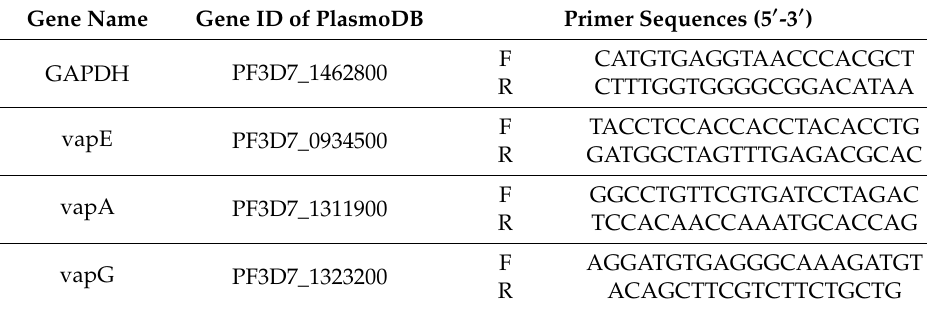
Table 4. Primer sequences of genes tested by